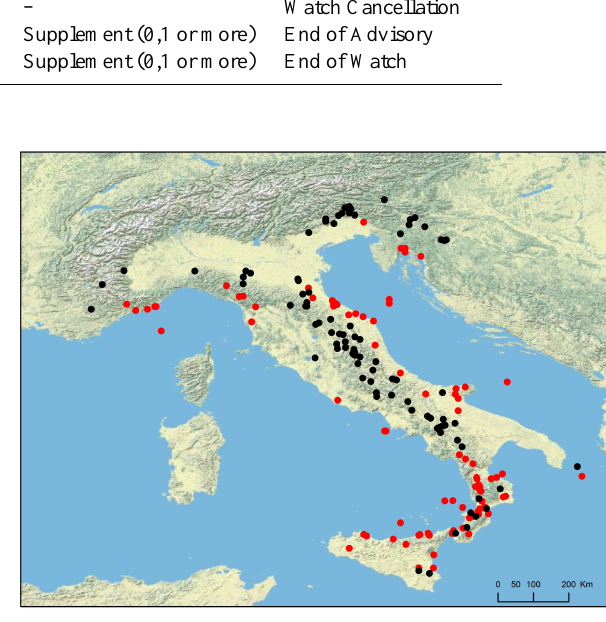
Fig. 1. Geographical distribution of the 178 CPTI04 earthquakes filtered by the DM according to the conditions: hypocentre less than 100km and (1) 5.5 <M w ≤ 6.5 and D ≤ 40km (red solid circles); or (2) M w > 6.5 and D ≤ 100km (black solid circles). Here D is the epicentral distance from the nearest